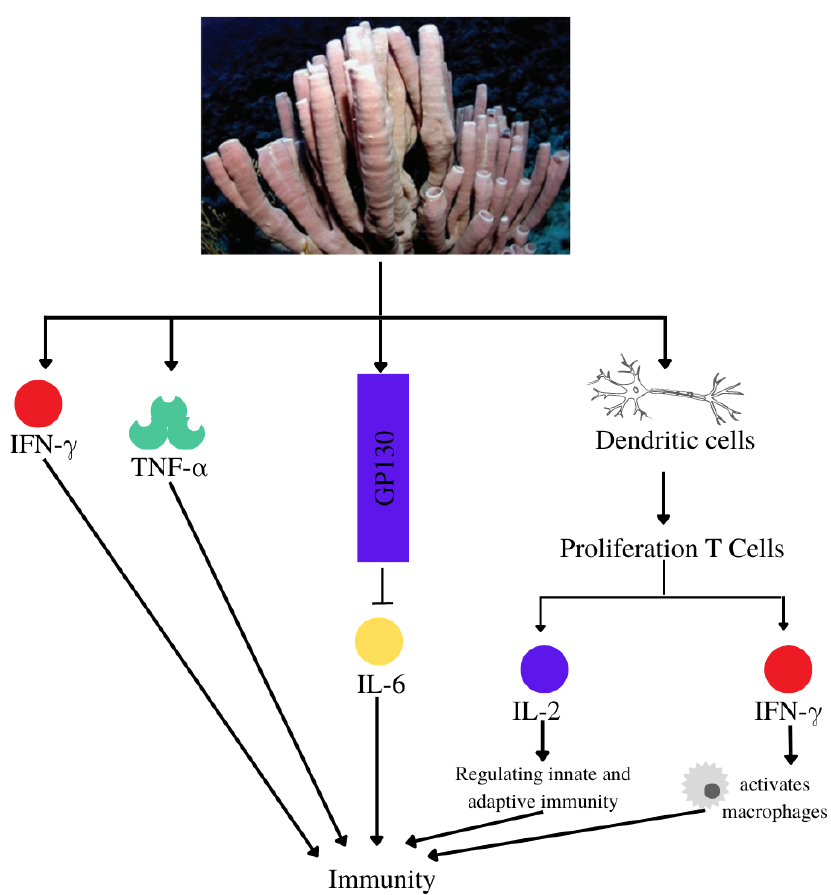
Figure 10. Immunomodulatory mechanisms of compounds from the subgenus Callyspongia .